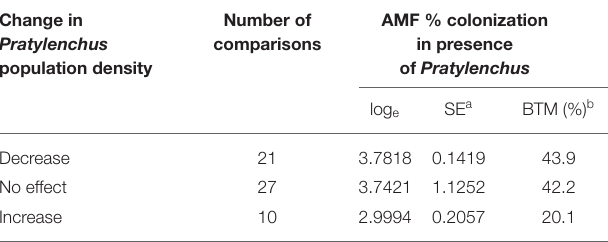
TABLE 5 | Effects of AMF inoculation on change in Pratylenchus population densities in relation to degree of AMF colonization in the roots. Change in